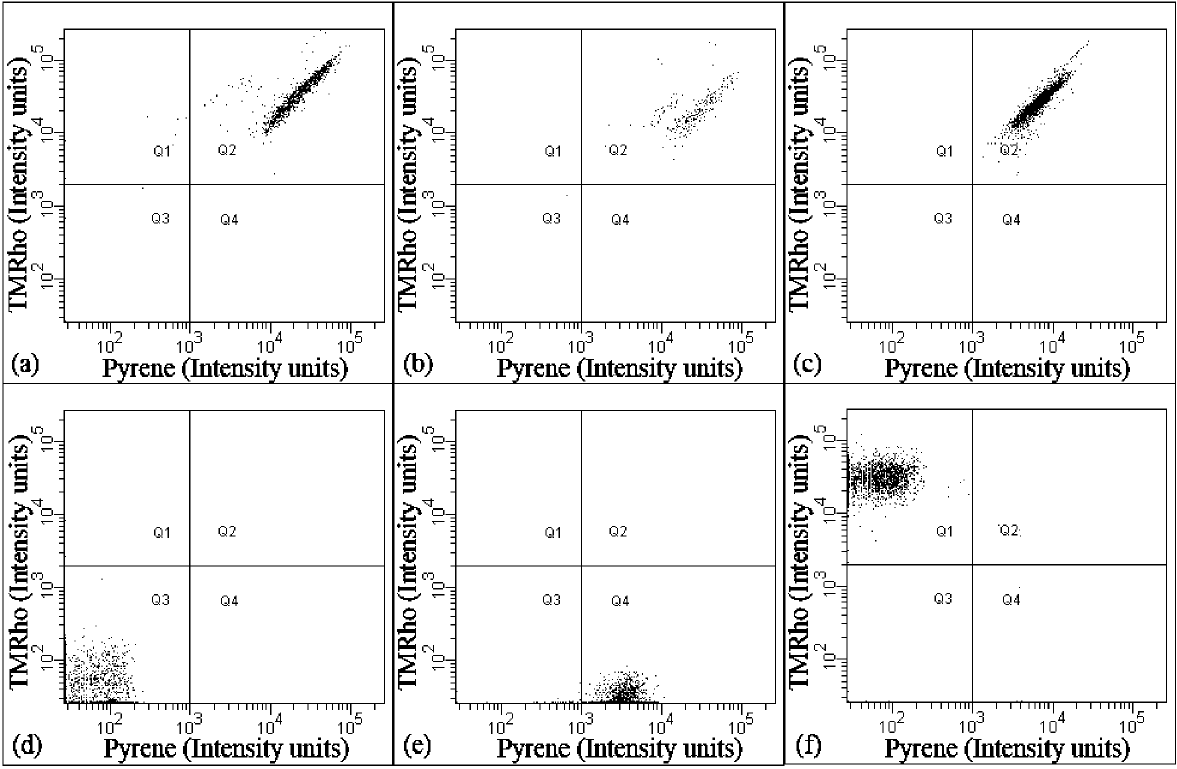
Figure 2. Flow-cytometric analysis of vesicle samples of ( a ) PB-PEO/POPC (75:25); ( b ) PB-PEO/POPC (50:50); ( c ) PB-PEO/POPC (25:75). The samples have been labeled with TMRho-PB-PEO and pyrene-PE to confirm the presence of hybrid vesicles in the population; ( d ) Control PB-PEO sample (unlabeled); ( e ) Control PB-PEO sample (pyrene-labeled); and ( f ) Control PB-PEO sample (TMRho-labeled). The x and y axes of each dot plot represent the fluorescence intensity of pyrene and TMRho, respectively.